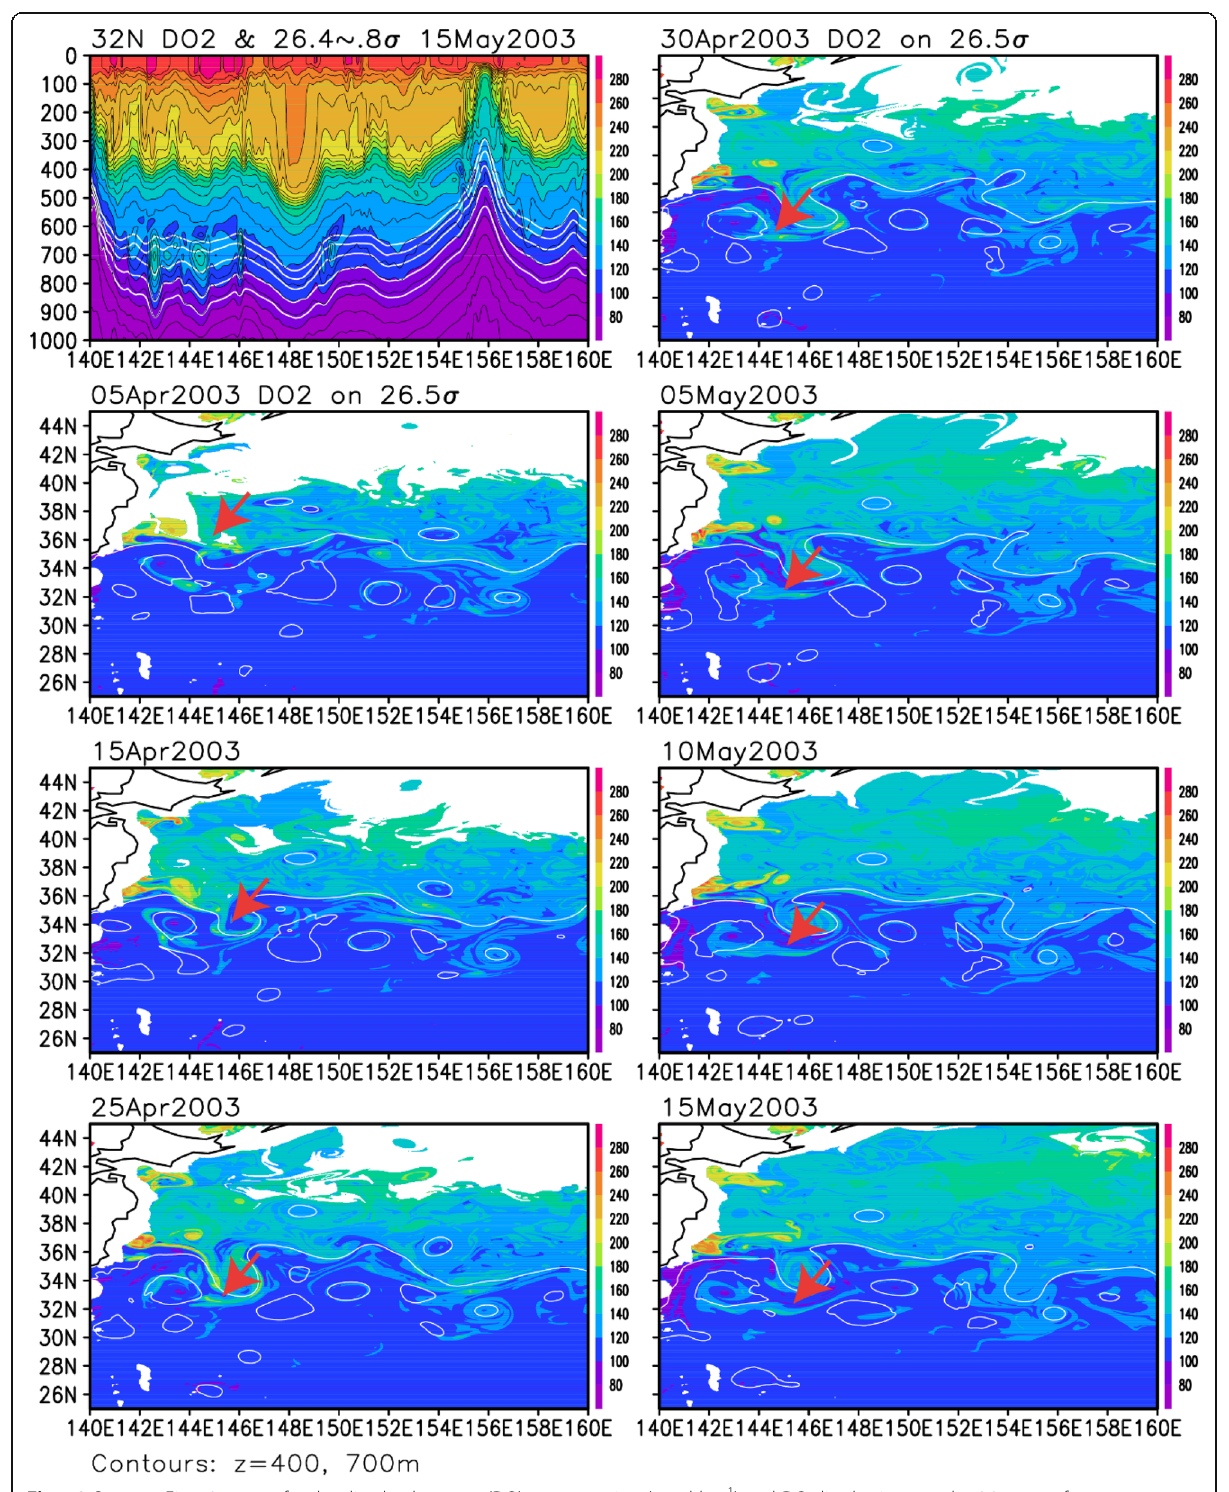
Fig. 13 Same as Fig. 12 except for the dissolved oxygen (DO) concentration ( μ mol kg − 1 ) and DO distributions on the 26.5 σ θ